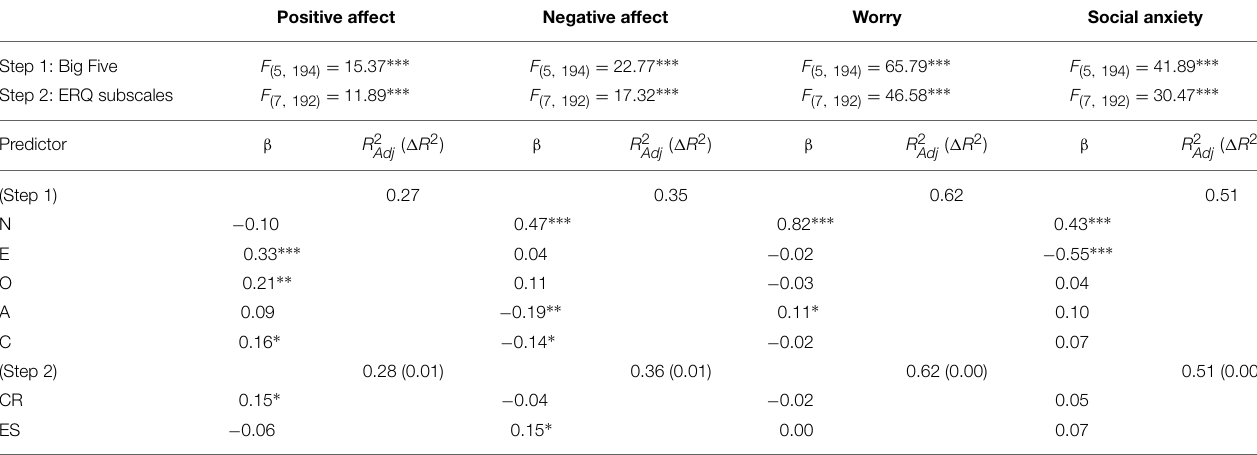
TABLE 3 | Hierarchical regression analyses predicting emotion-laden criteria from the Big Five (Step 1) and the two ERQ subscales (Step 2). Positive affect Negative affect Worry Social anxiety